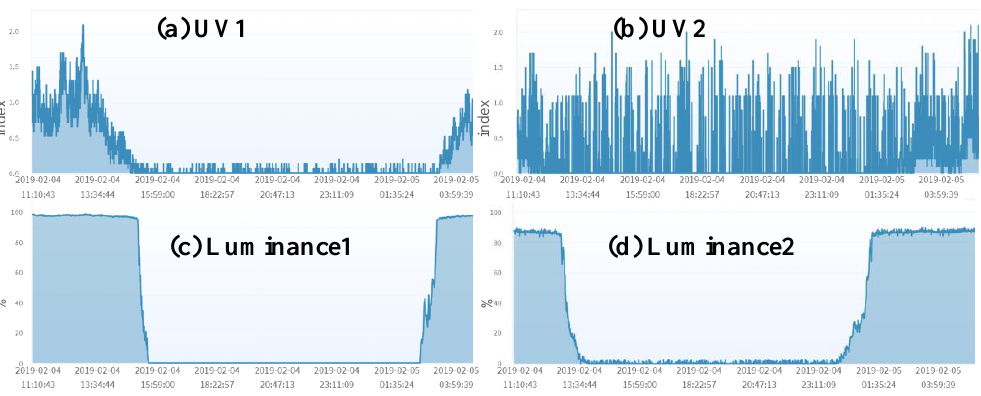
Figure 13. Luminance and UV (Longtan).